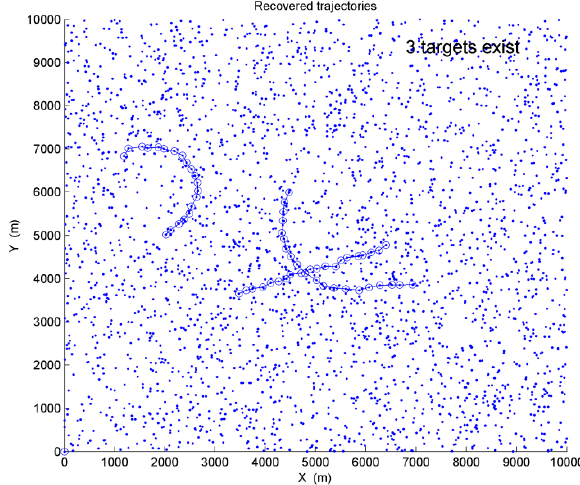
Figure 10. Recovered trajectories and estimated target number (Scenario-3, “-o-” represents the recovered trajectories of the targets, “ ⋅ ” represents the